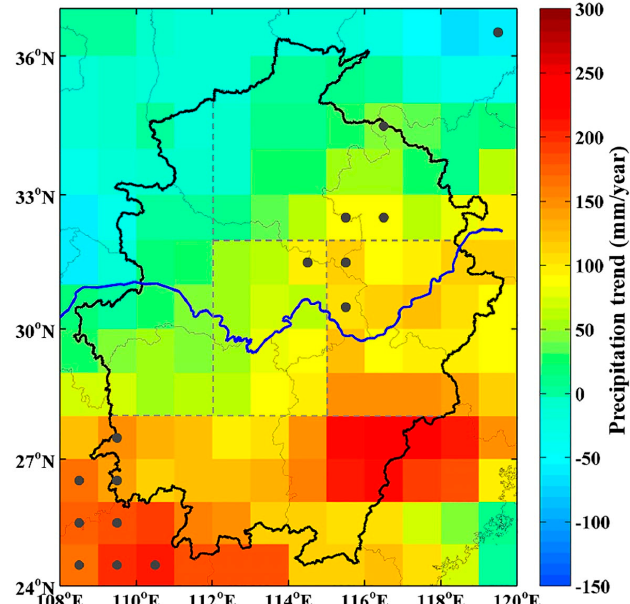
Figure 8. Annual precipitation trend over central China from 2011 to 2015. Regions with significant trends ( p value < 0.05) are indicated by dots.